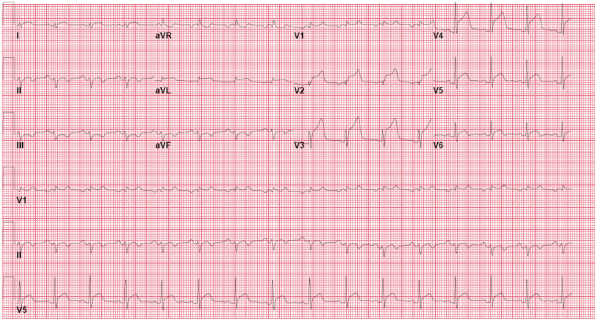
Figure 3: Twelve-lead electrocardiogram on hospital day 7 showed persistent diffuse ST elevation.